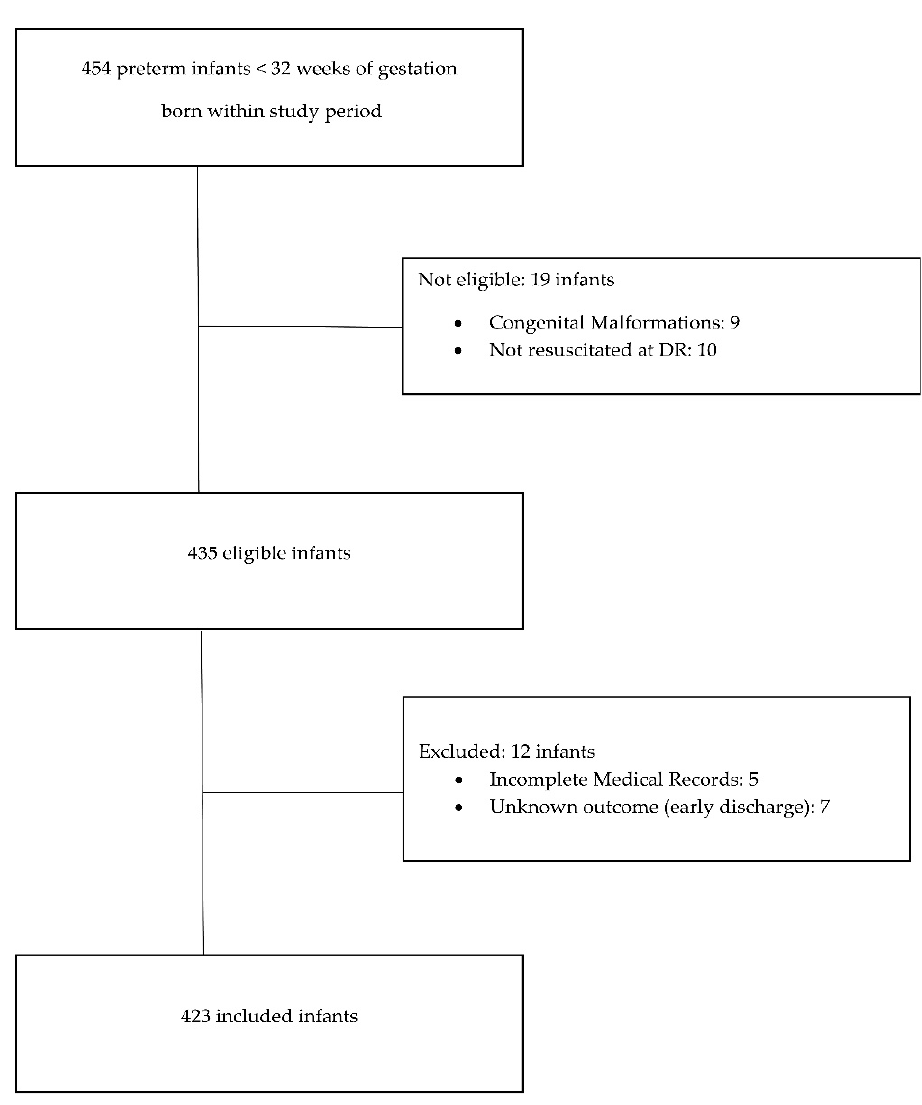
Figure 1. Flow chart. DR = delivery room.